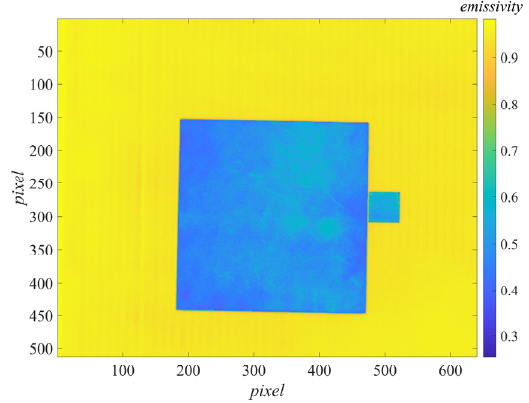
Figure 9. Measured emissivity image by our method.